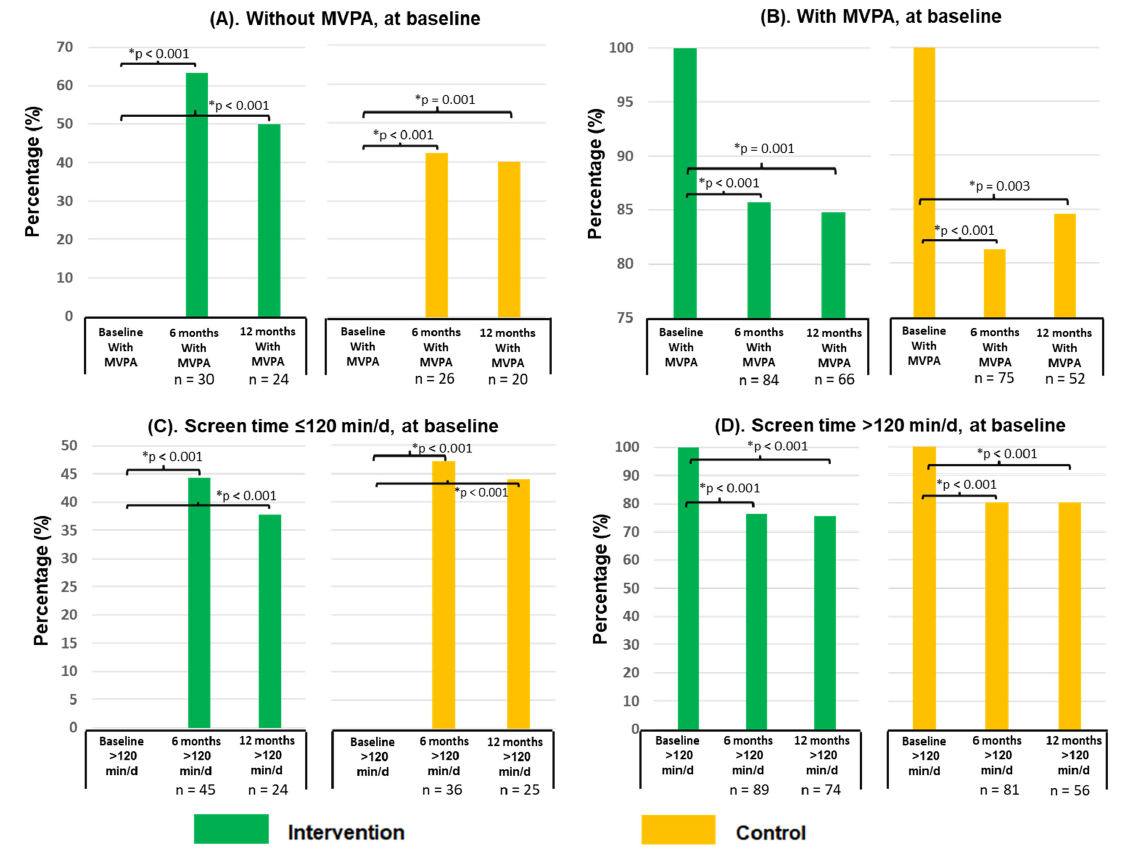
Figure 2. Stratified analysis of the effect of the intervention according to the performance at the beginning of the study or not of MVPA and the amount of time in front of screens. MVPA: moderate to vigorous physical activity; * test for equality of proportions.